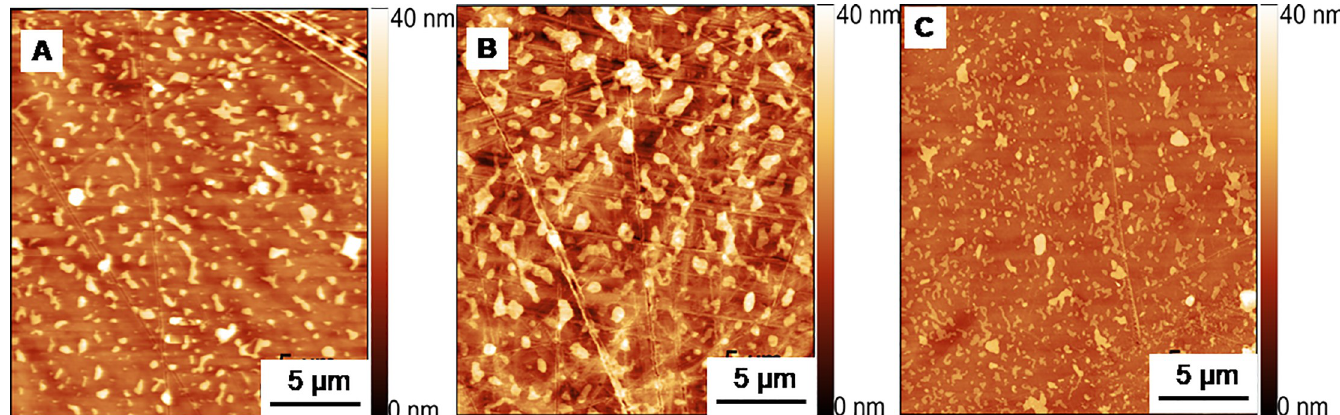
Fig 5. AFM micrograph of Petri dish surfaces incubated for 1 h with 3% PEG6000 from (A) C.E.; (B) Merck; and (C) S.A. The images were recorded after replacing the PEG solution with Milli-Q water. The scale bars indicate 5 μ m.